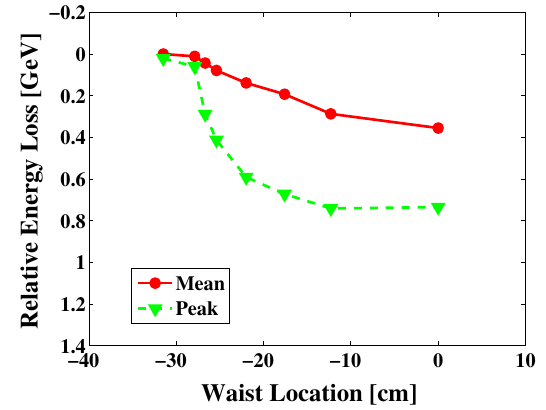
FIG. 12. (Color) Changing charge (Li)—The average and peak energy loss results from OOPIC .